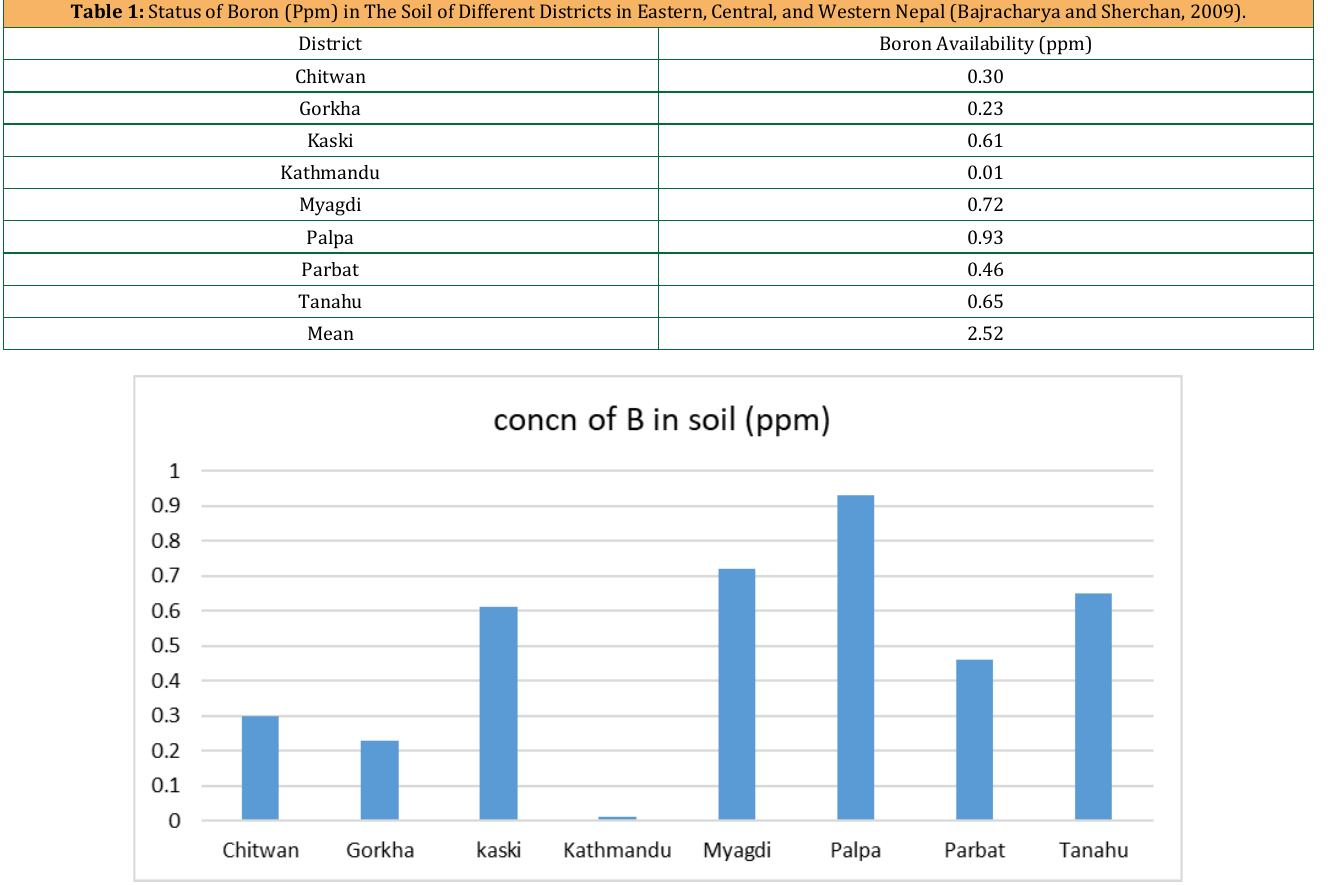
Figure 1: Status of Boron in Different Cultivated Regions o f Nepal Table 2: Status of Boron in Various Districts of Three Physiographic Regions of Nepal (Bajracharya and Sherchan, 2009). Region of